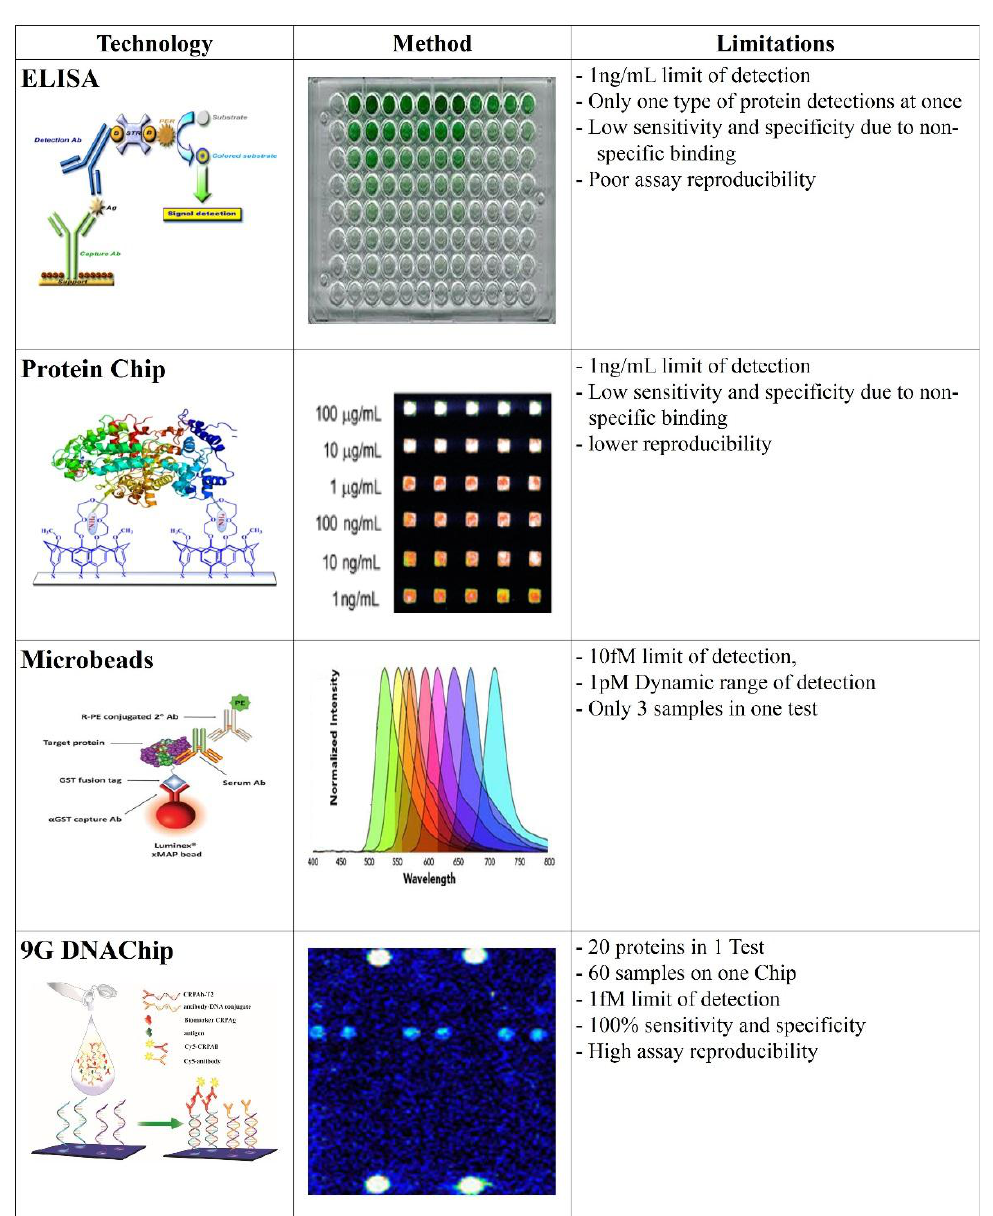
Figure 8. Advancements in the biomarker detection technologies and their